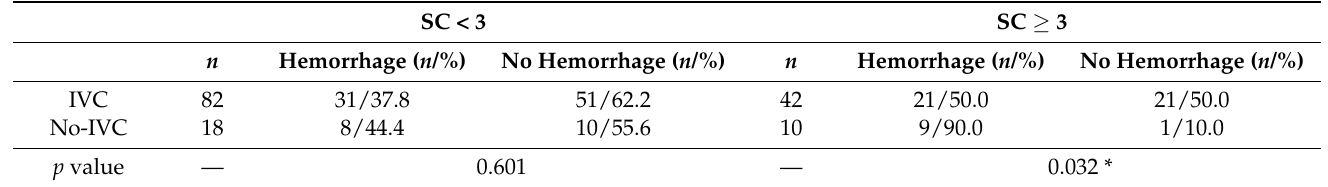
Table 4. Bleeding analysis for PDR complexity subgroup ( n /%).